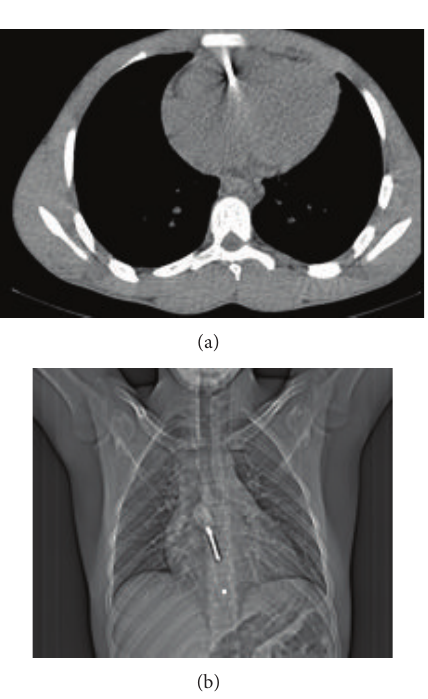
Figure 2: CT scan images of screwdriver inside the heart.